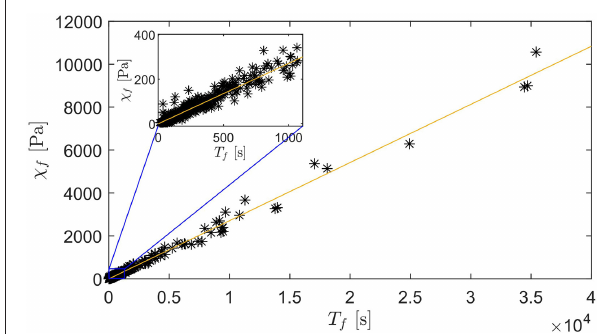
FIGURE 9 | Correlation between the avalanche size T f (in seconds), and the respective valley size χ f (in Pascals). The Pearson’s correlation coefficient was measured to be ρ =